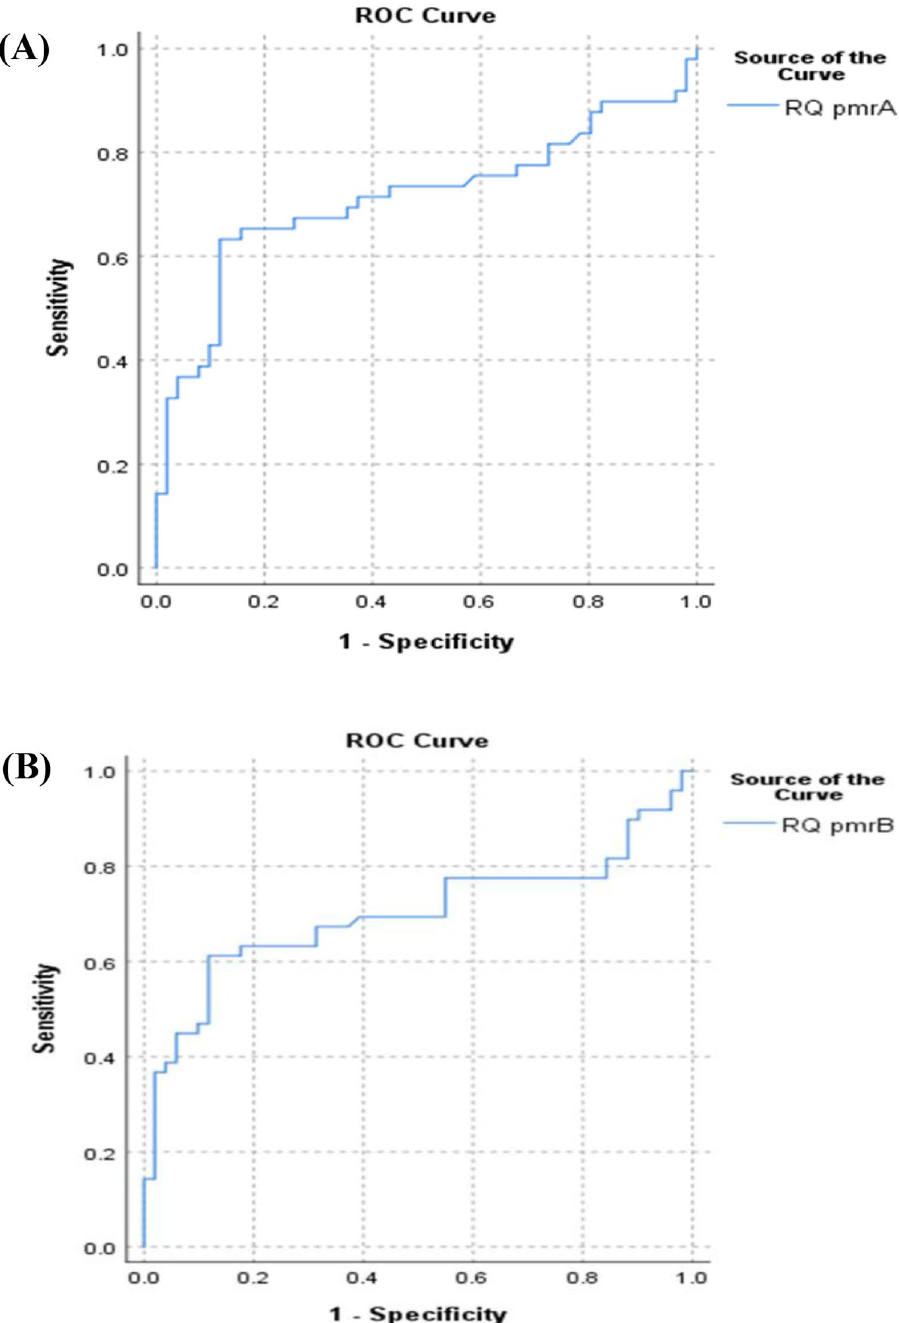
Figure 2. ( A ) Receiver operating characteristic curve of pmrA expression (AUC 0.713, P < 0.001). ( B ) Receiver operating characteristic curve of pmrB expression (AUC = 0.699, P <